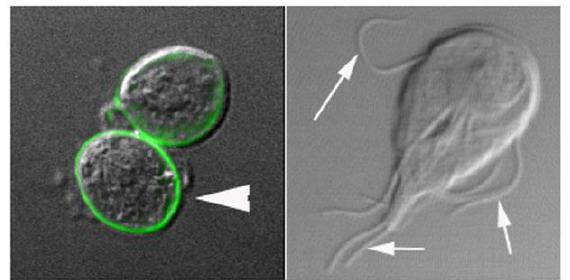
FIGURE 1 . (A) Immunofluorescence and differential interference contrast image of Giardia cysts (arrowhead). The cyst wall protein 1 (green) is observed forming the cyst wall. (B) Differential interference contrast image of a trophozoite. The flagella are indicated